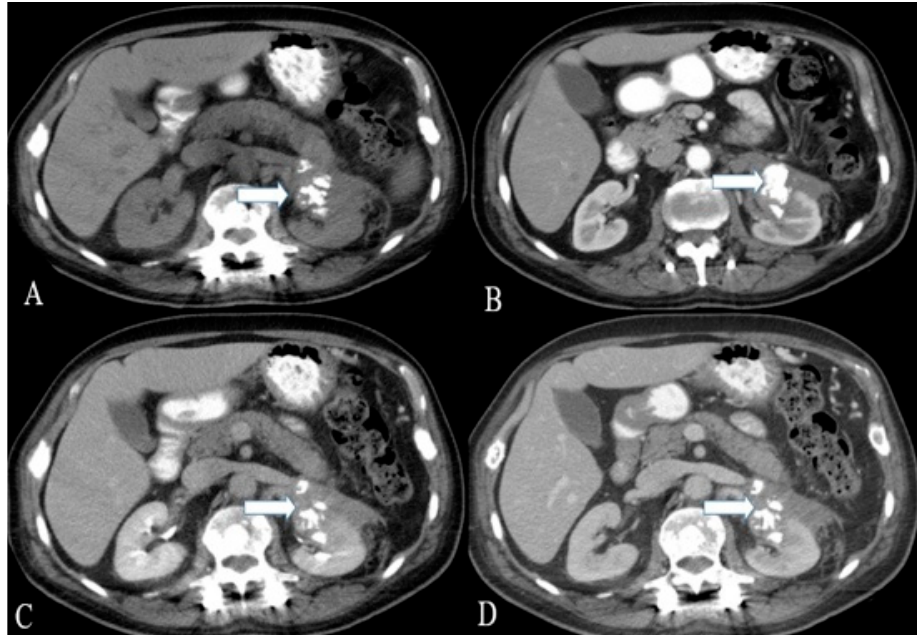
Figure 3. A 36-year-old female with renal NENs. CT of the abdomen before ( A ) and after oral and IV contrast administration in ( B ) arterial, ( C ) porto-venous, and ( D ) delayed phases reveal a 5.3 × 3.9 cm partially calcified mass (arrows) arising from the left kidney, extending to the left perinephric space, and abutting the tail of the pancreas. Pathology revealed small-cell carcinoma with neuroendocrine differentiation.